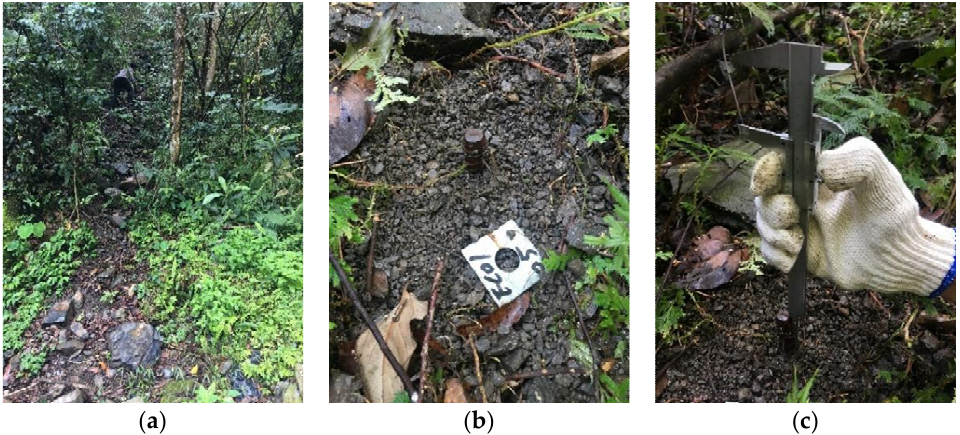
Figure 2. Illustration of field measurements in the Shihmen Reservoir watershed: ( a ) a natural slope, ( b ) an erosion pin and its label, and ( c ) measuring with a caliper (( c ) from [22]).